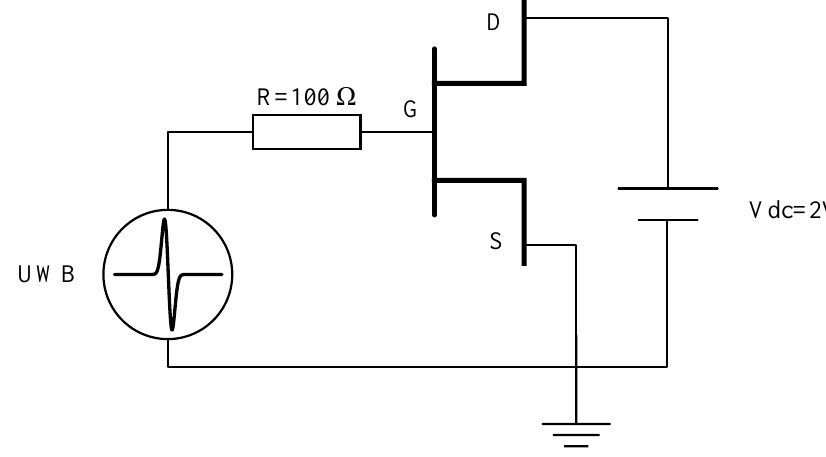
Figure 4. Schematic diagram of simulation circuit.